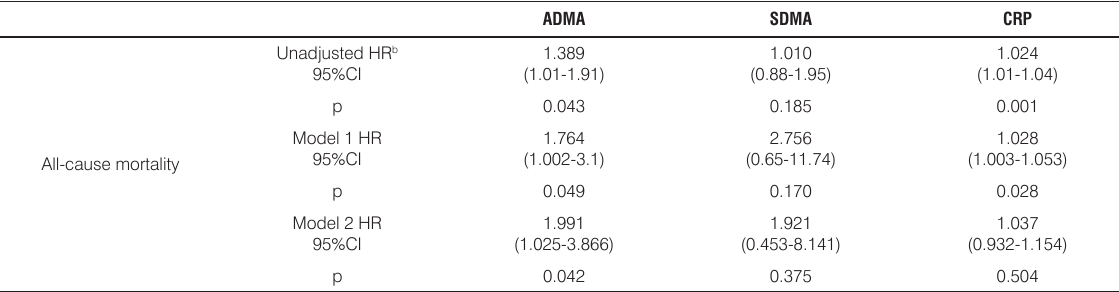
Model 1 adjusted for age, sex, and smoking; Model 2 adjusted for age, sex, hypertension, coronary disease, history of diabetes, cholesterol. HR is per 1SD of ADMA (0.20 µmol/L)